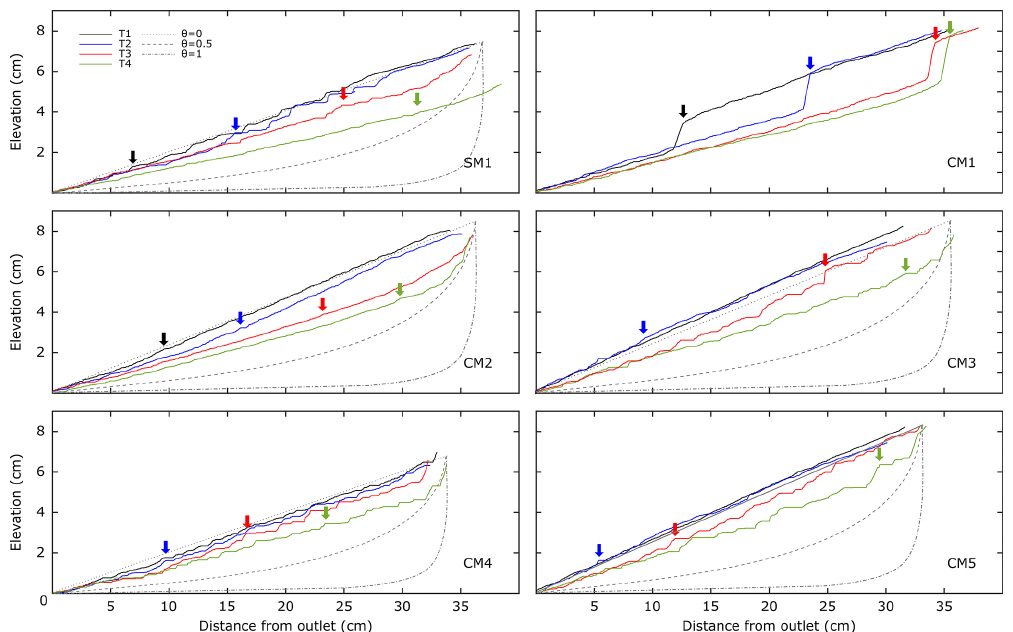
Figure 7. Longitudinal profiles of the streams highlighted in Fig. 5. This analysis is performed by converting the laser scan into a DEM and applying the TopoToolbox tool for MATLAB (Schwanghart and Scherler, 2014). The laser horizontal and vertical resolutions are 0.05 and 0.07mm, respectively. We show four profiles corresponding to four consecutive time steps (T1 = 20min, T2 = 60min, T3 = 150min, T4 = 350min). The vertical arrows point to the main knickpoints for the relative time step (color coding). In the figure theoretical river profiles for a concavity index of 0, 0.5 and 1 are also plotted. We did not plot the theoretical profile for CM1 because no proper channel develops (see text for